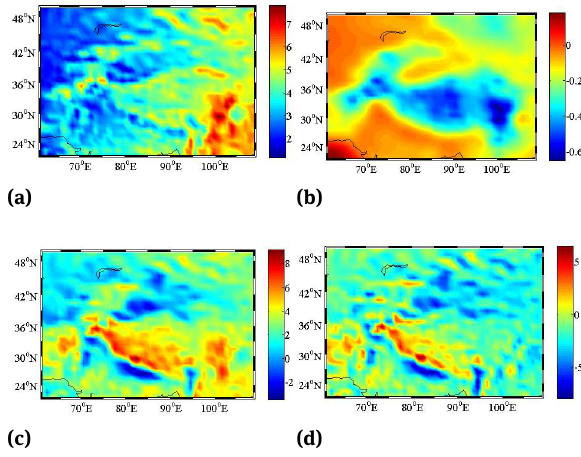
Figure 5: Maps of differences between Moho depths computed by a) VMM - SVMM, b) SFLEX and FLEX, c) SVMM – FLEX and d) VMM - FLEX